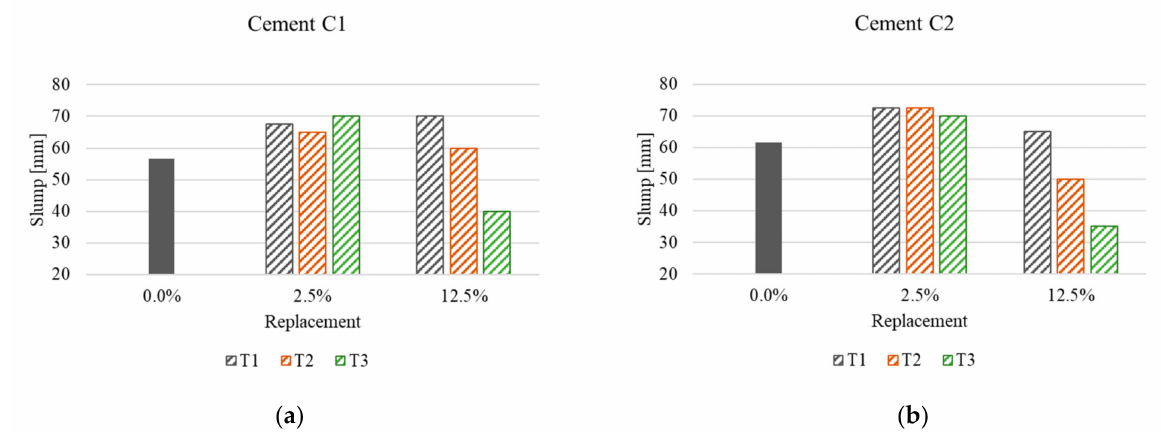
Figure 4. Mortar cone slump with addition of untreated rubber 2.5% and 12.5% replacement: ( a ) cement C1; ( b ) cement C2.